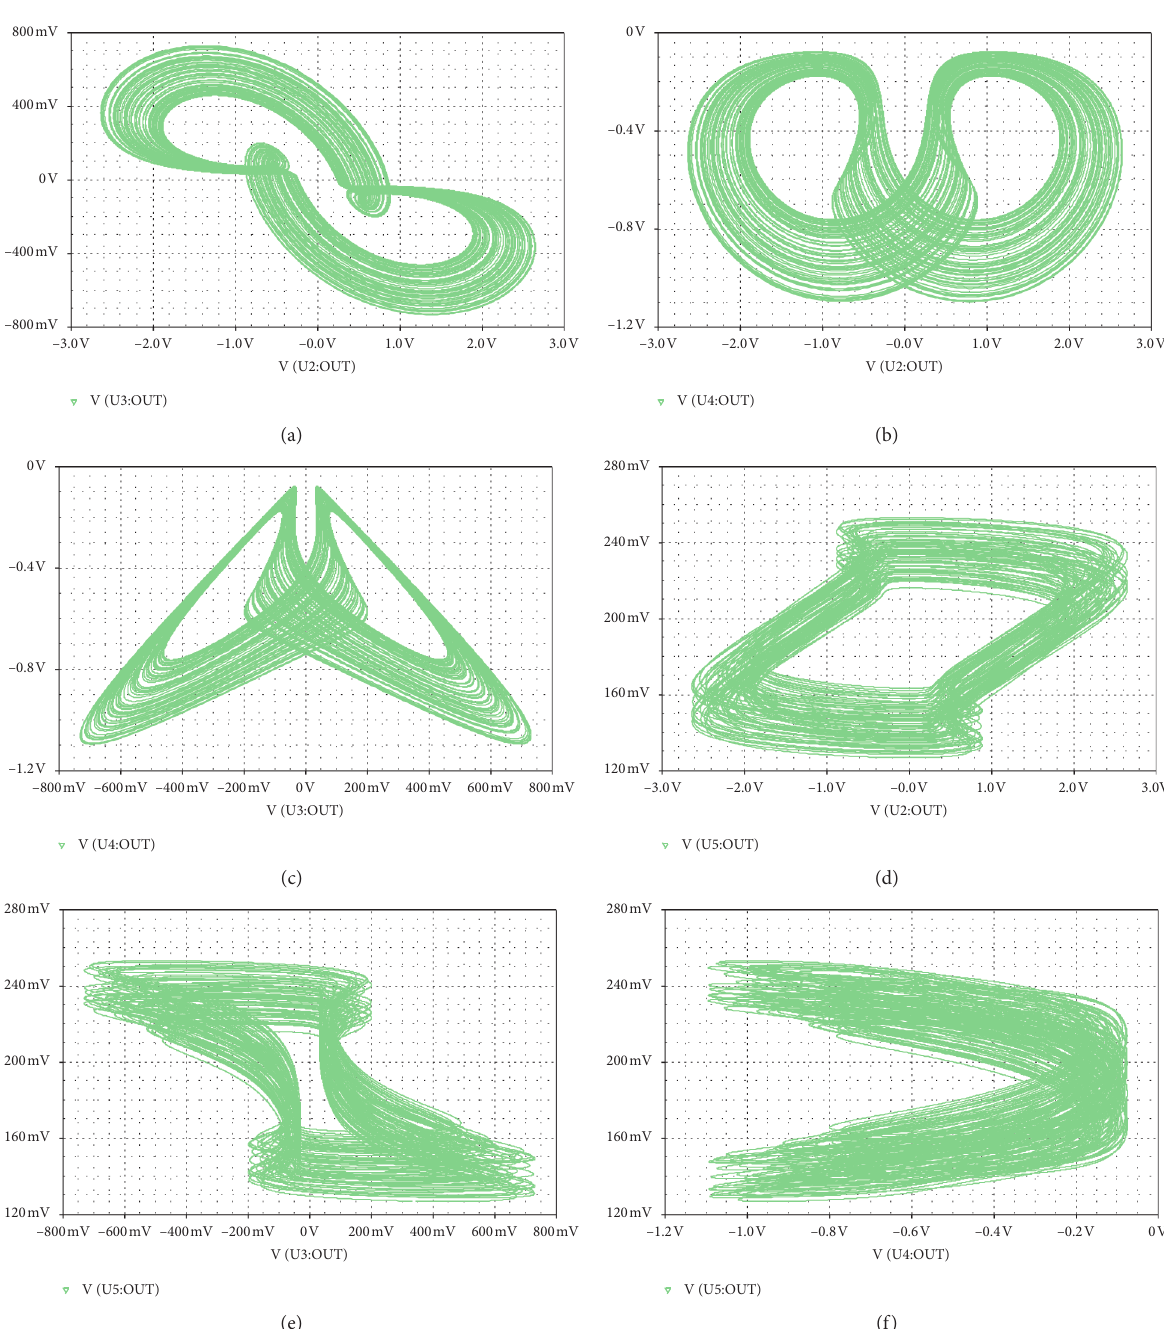
Figure 17: PSpice simulated phase portraits of chaotic attractors with initial voltages (− 1 V , 0 . 1 V , 0 V , 0 V )